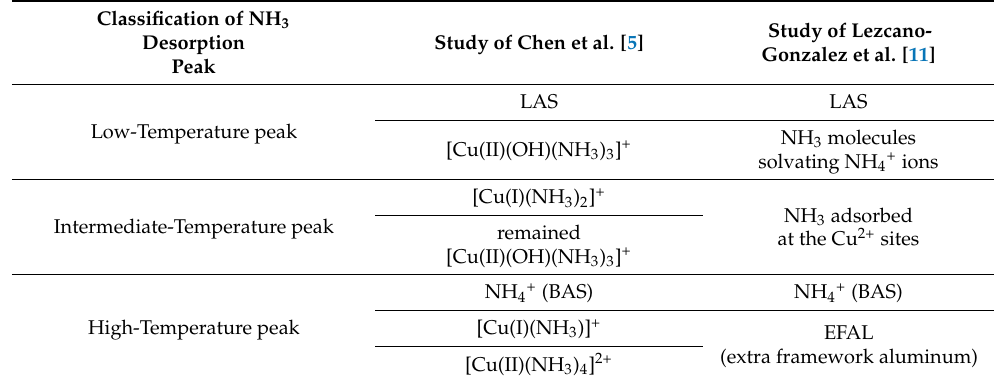
Table 1. NH 3 adsorption form organizing the NH 3 adsorption peak by temperature, as mentioned in various literature and